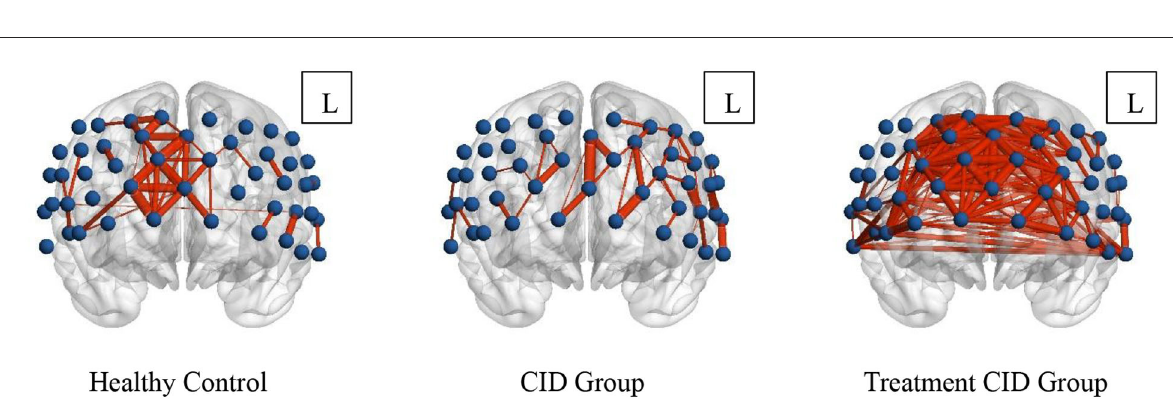
one of the targets of drug therapy likely promotes sleep.